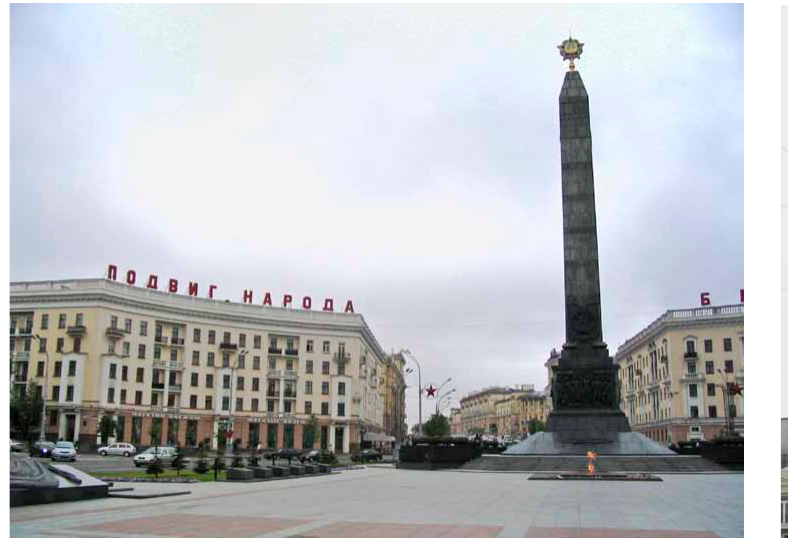
lithuania. r. Čepaitienė